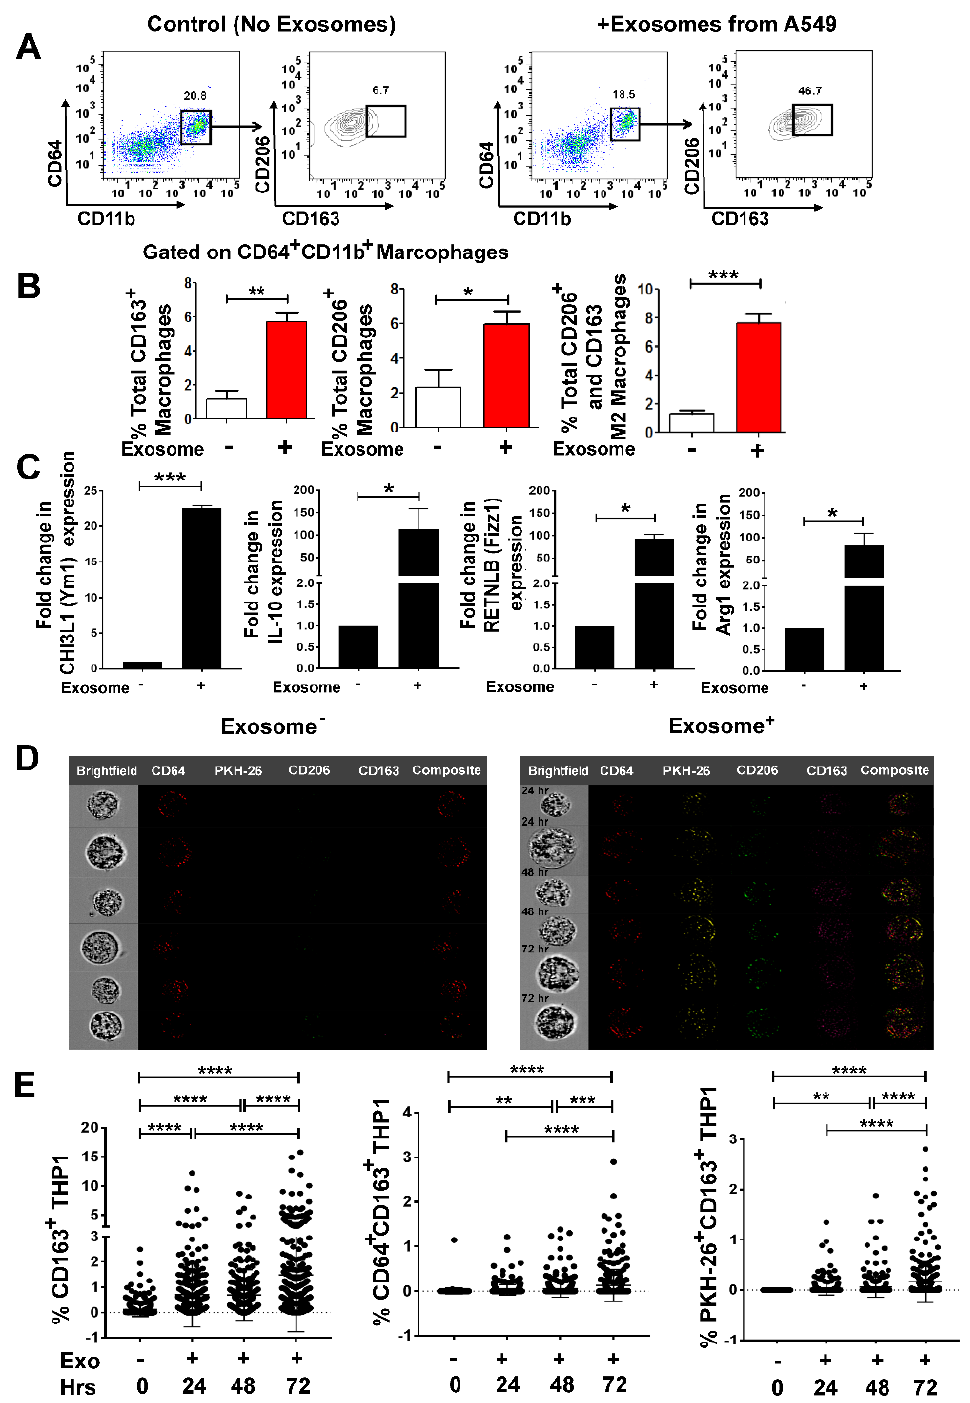
Figure 3. A549 cell-derived exosomes differentiate non-committed M0 macrophages to M2 phenotype. A549 human lung cancer cells were cultured in exosome depleted media for 24 h. Exosomes were isolated from cultured supernatant using differential centrifugation. Exosomes were stained with PKH-26 for overnight. THP-1 cells were seeded and transformed into M0 macrophages upon overnight stimulation with PMA (20 – 100 ng/mL). M0 macrophages were then co-cultured with PKH-26 stained, A549 derived exosomes in 10:1 ratio (10 exosomes/cell) for 24 to 72 h. ( A ) Representative flow cytometry plot showing in-vitro induction of M2 phenotype (CD11b + CD64 + CD163 + CD206 + ) with A549-derived exosomes. ( B ) Left to right panel-Total percentage of CD163 + macrophages, showing significant increase in CD163 + macrophages that have internalized PKH + exosomes. Total percentage of CD206 + macrophages, showing significant induction in CD206 +